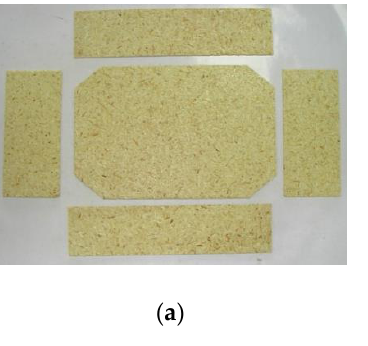
Figure 2. ( a ) Board pieces, ( b ) container type.